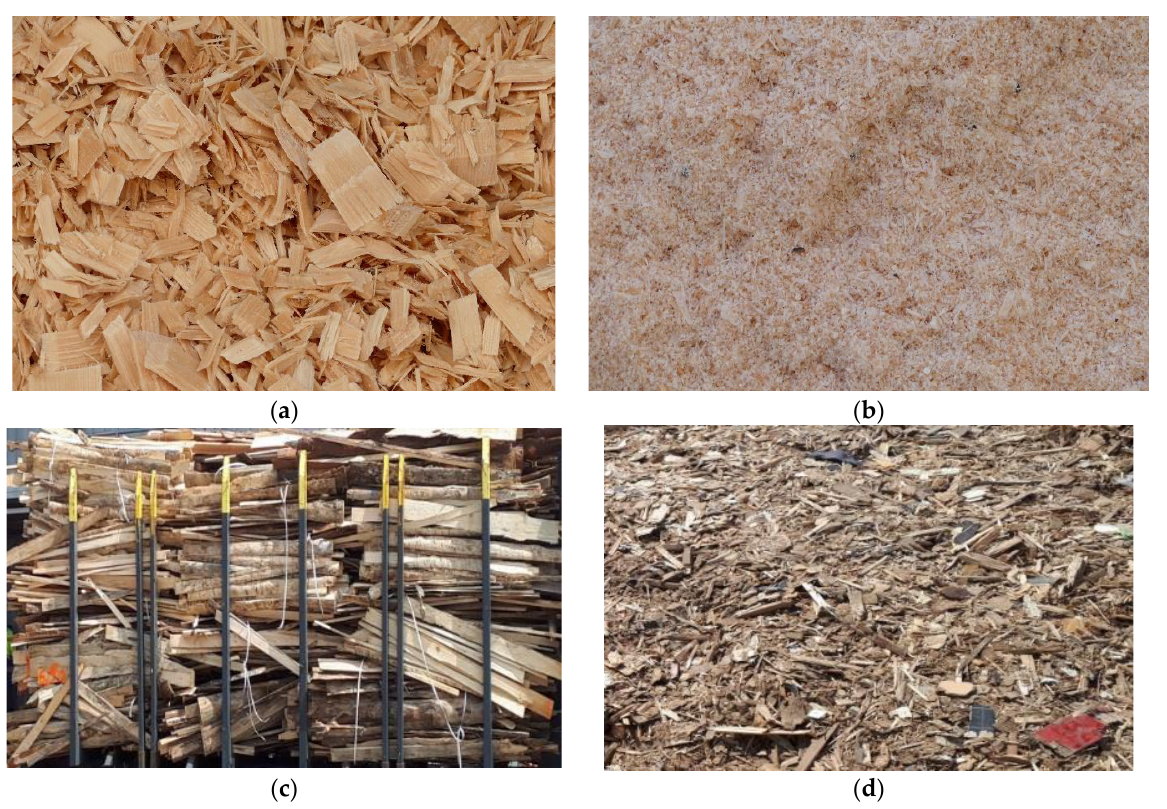
Figure 1. Transported sawmill by-product assortments: ( a ) wood chips, ( b ) sawdust, ( c) slabs, ( d ) recycled wood.